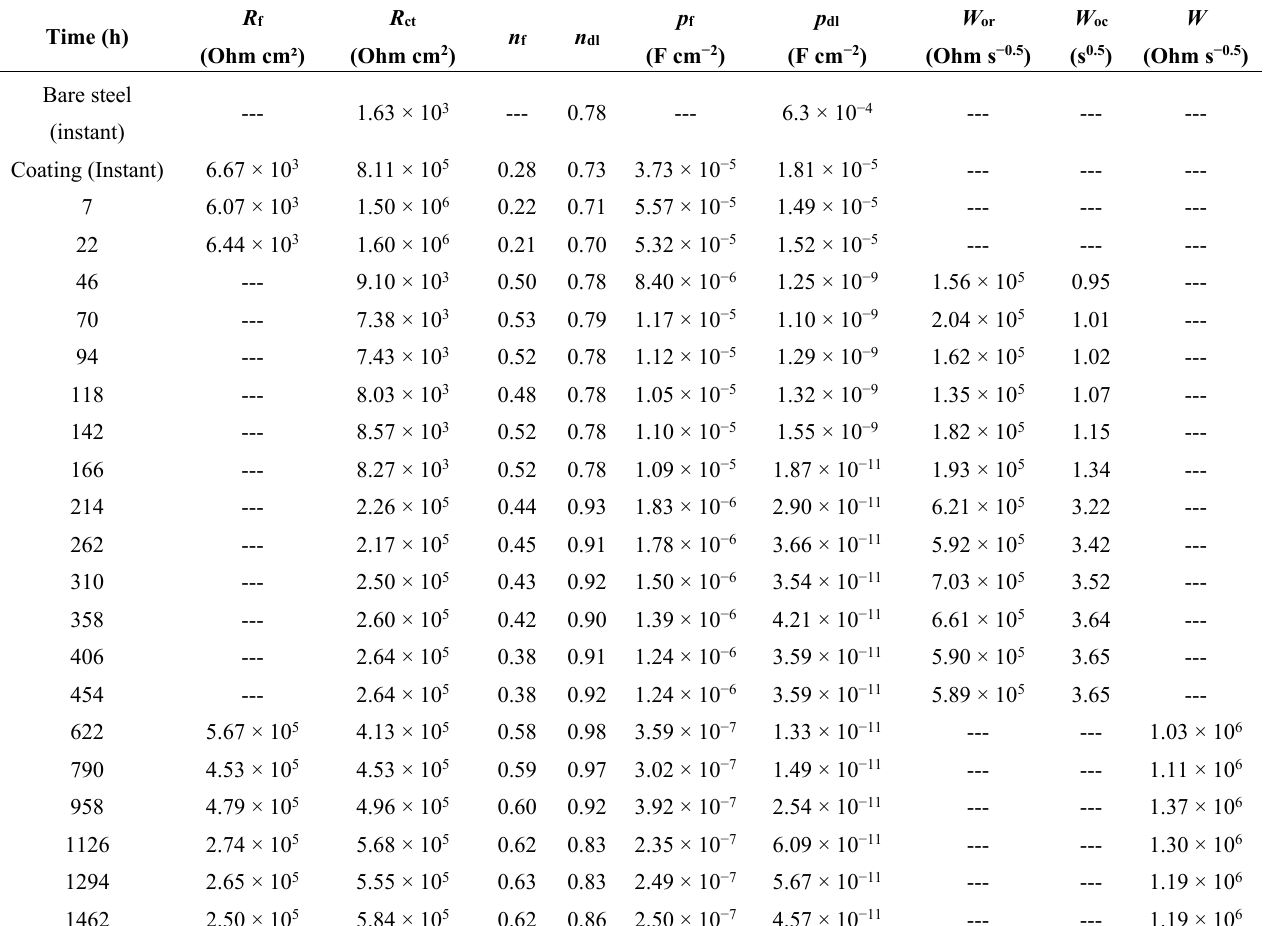
Table 2. Extracted electrochemical impedance spectroscopy (EIS) parameters for the bare and the coated steel at different immersion